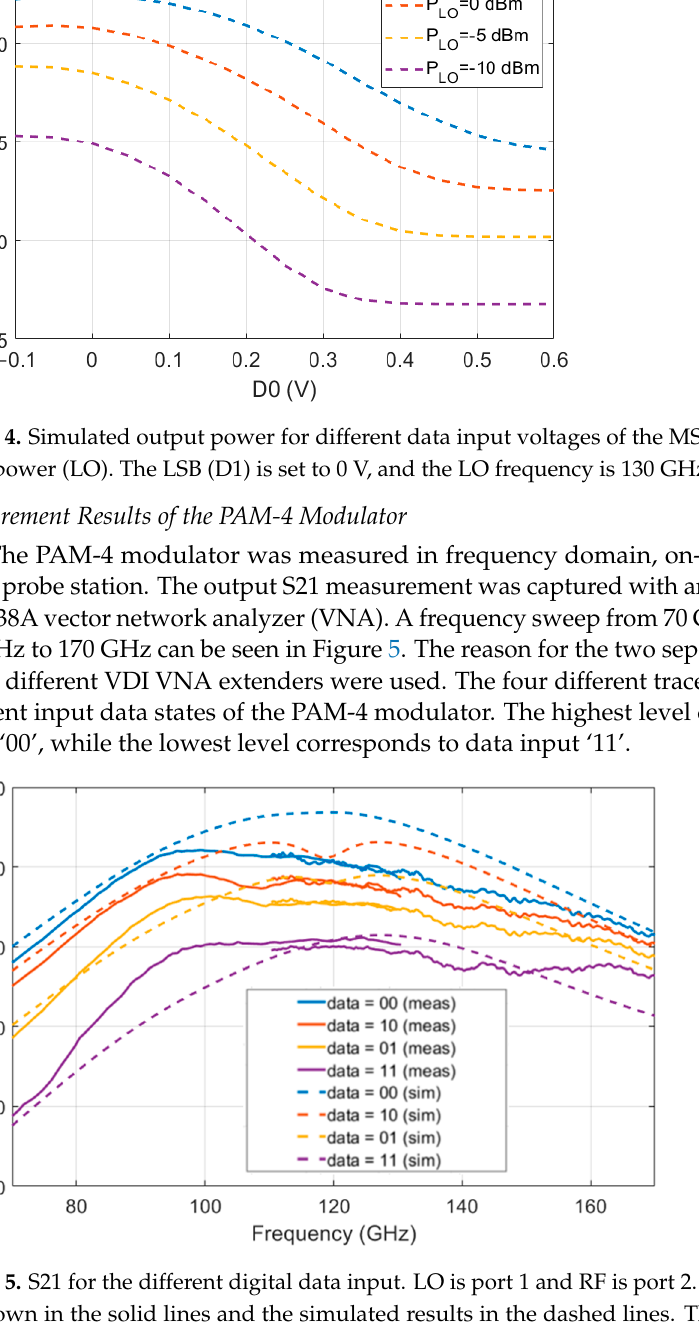
Figure 3. A photo of the fabricated RF-DAC. The chip size including pads is 740 µm by 740 µm.